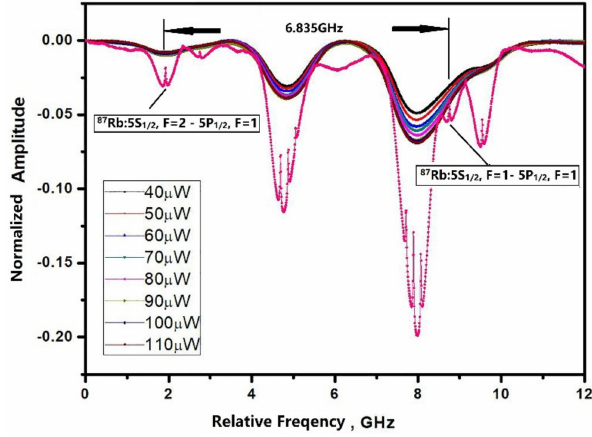
Figure 6. Optical absorption lines obtained in a cm-scale pure Rb reference cell (Pink dot) compared to a Rb-N 2 microfabricated cell heated at 90 ◦ C with laser power from 40 µ W to 110 µ W.